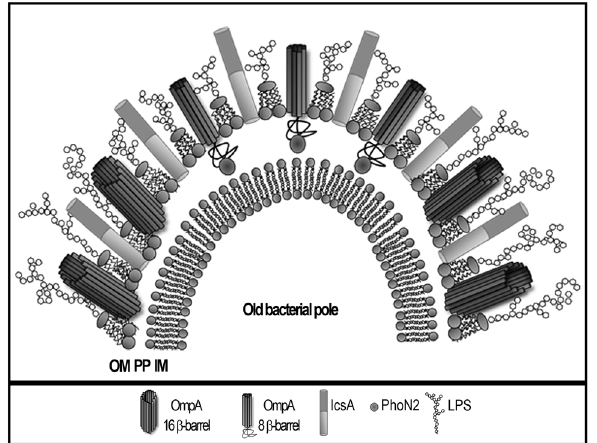
Figure 8. Model of the role of periplasmic PhoN2 in S.flexneri in proper IcsA exposition. Polarly localized PhoN2, by binding the C- terminal periplasmic domain of OmpA only at the old bacterial pole, stabilizes OmpA in the small pore conformation thereby enabling proper IcsA exposition and function.